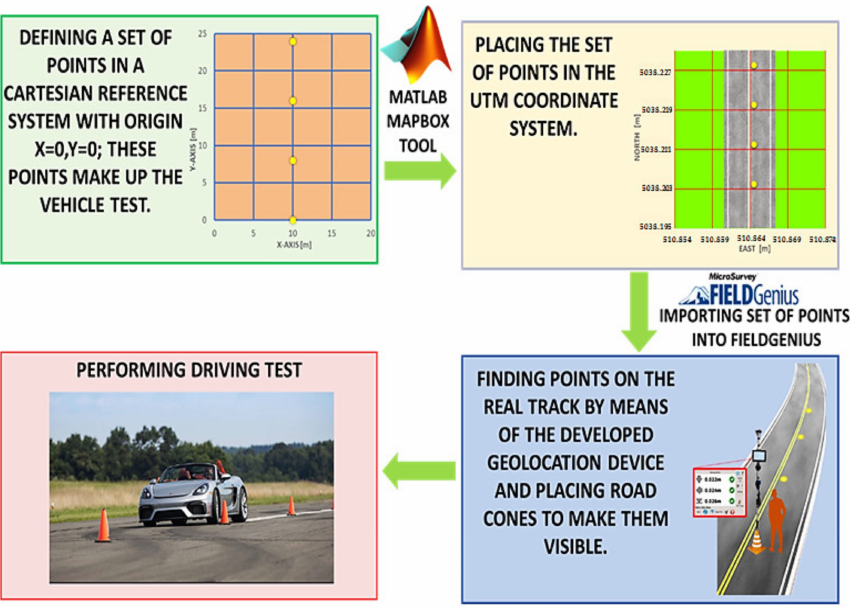
Figure 4. Activity flow to place a set of points on a track according to the specific standard. FieldGenius software guides the user sequentially to the points, providing indications related to the distance required to reach each one in the north and east directions (Figure 5a); the compass aids the user to follow the FieldGenius indications. Once the target point has been reached, the user checks the pole verticality using the bubble and marks the point with a cone (Figure 5b). This operation is repeated for all the points of the test configuration (Figure 5c).